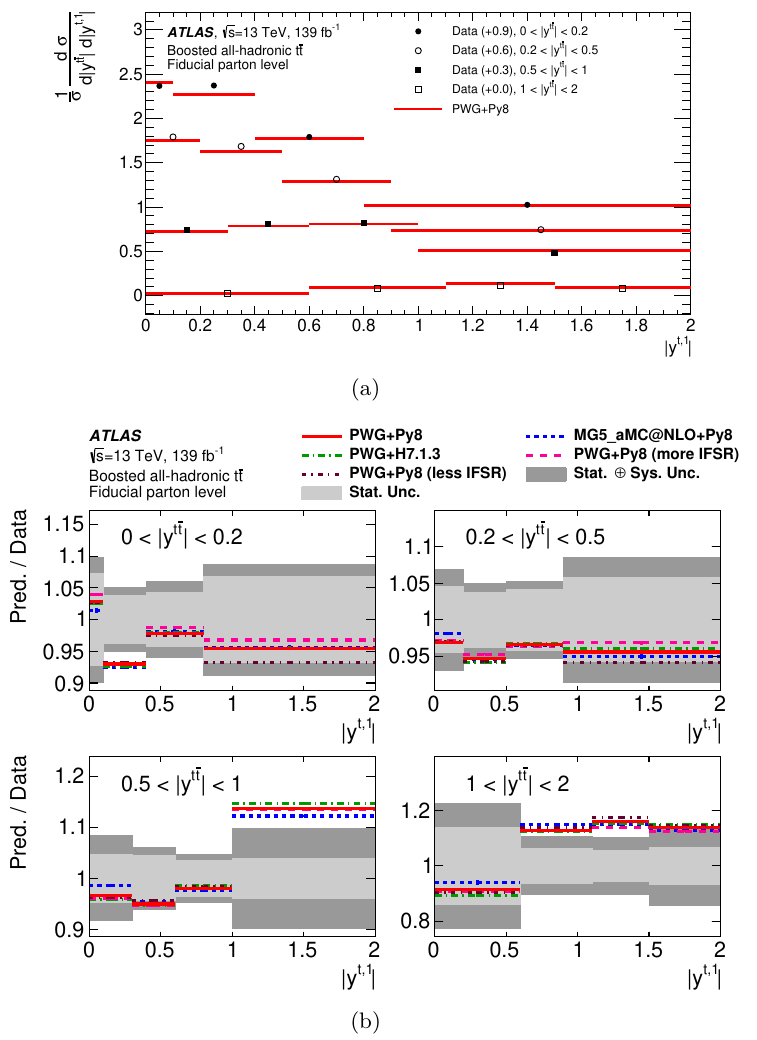
Figure 29 . (a) Normalized parton-level fiducial phase-space double-differential cross-sections as a function of the absolute value of the rapidity of the t ¯ t system, the rapidity of the leading top quark, compared with the Powheg+Pythia 8 calculation. Data points are placed at the centre of each bin and the Powheg+Pythia 8 calculation is indicated by solid lines. The measurement and the prediction are shifted by the factors shown in parentheses to aid visibility. (b) The ratios of various MC calculations to the normalized parton-level fiducial phase-space differential cross-sections. The dark and light grey bands indicate the total uncertainty and the statistical uncertainty, respectively, of the data in each